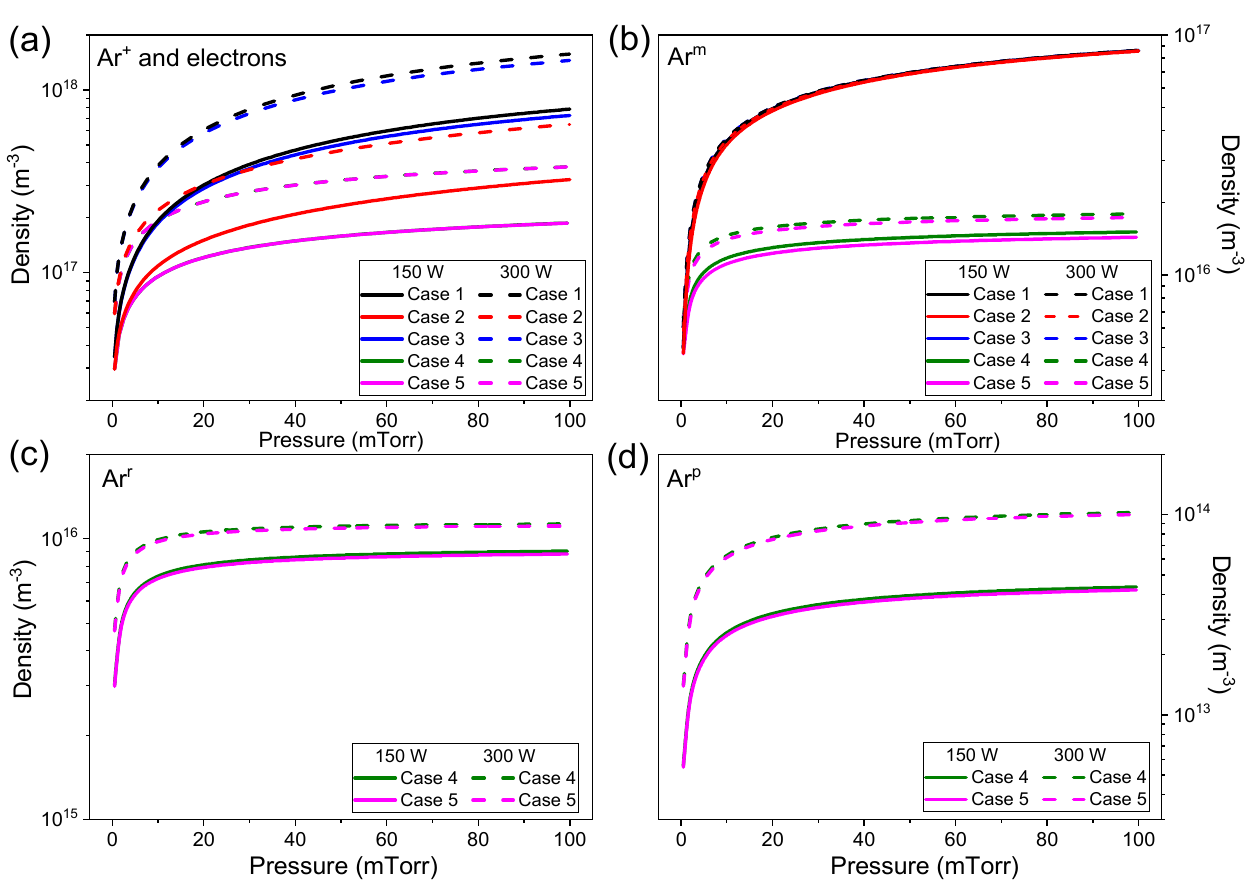
rate constants of these reactions (Figure 2). Thus, the densities of Ar r and Ar p are guided mainly by electron density (Figure 5c,d). Comparing the species densities of cases 4 and 5 (Figure 5), we see that the heavy species reactions did not change significantly to any particle density.